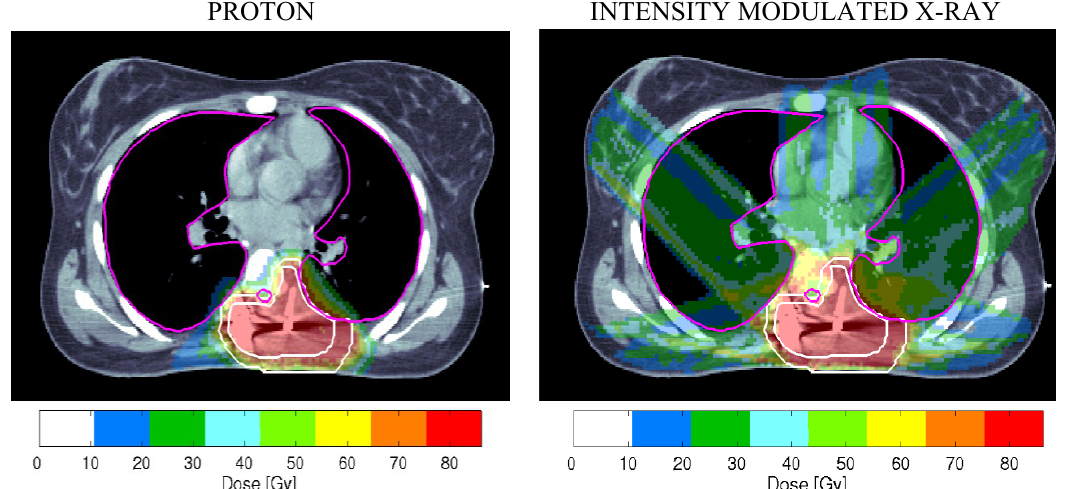
Figure 2. Some clinical dilemmas in particle therapy are shown in these dose distributions displayed on a CT scan of a female patient who has had incomplete surgery for a paravertebral epithelioid sarcoma. (Plan obtained with permission of J. Munzenrider, Massachusetts General